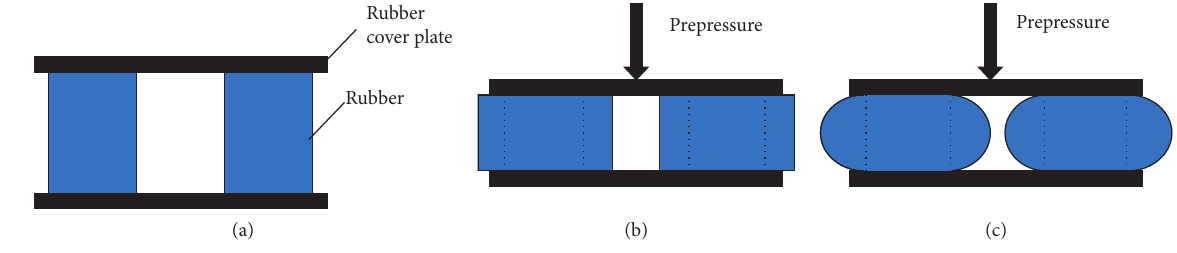
Figure 6: Compression deformation diagram of annular rubber pad.